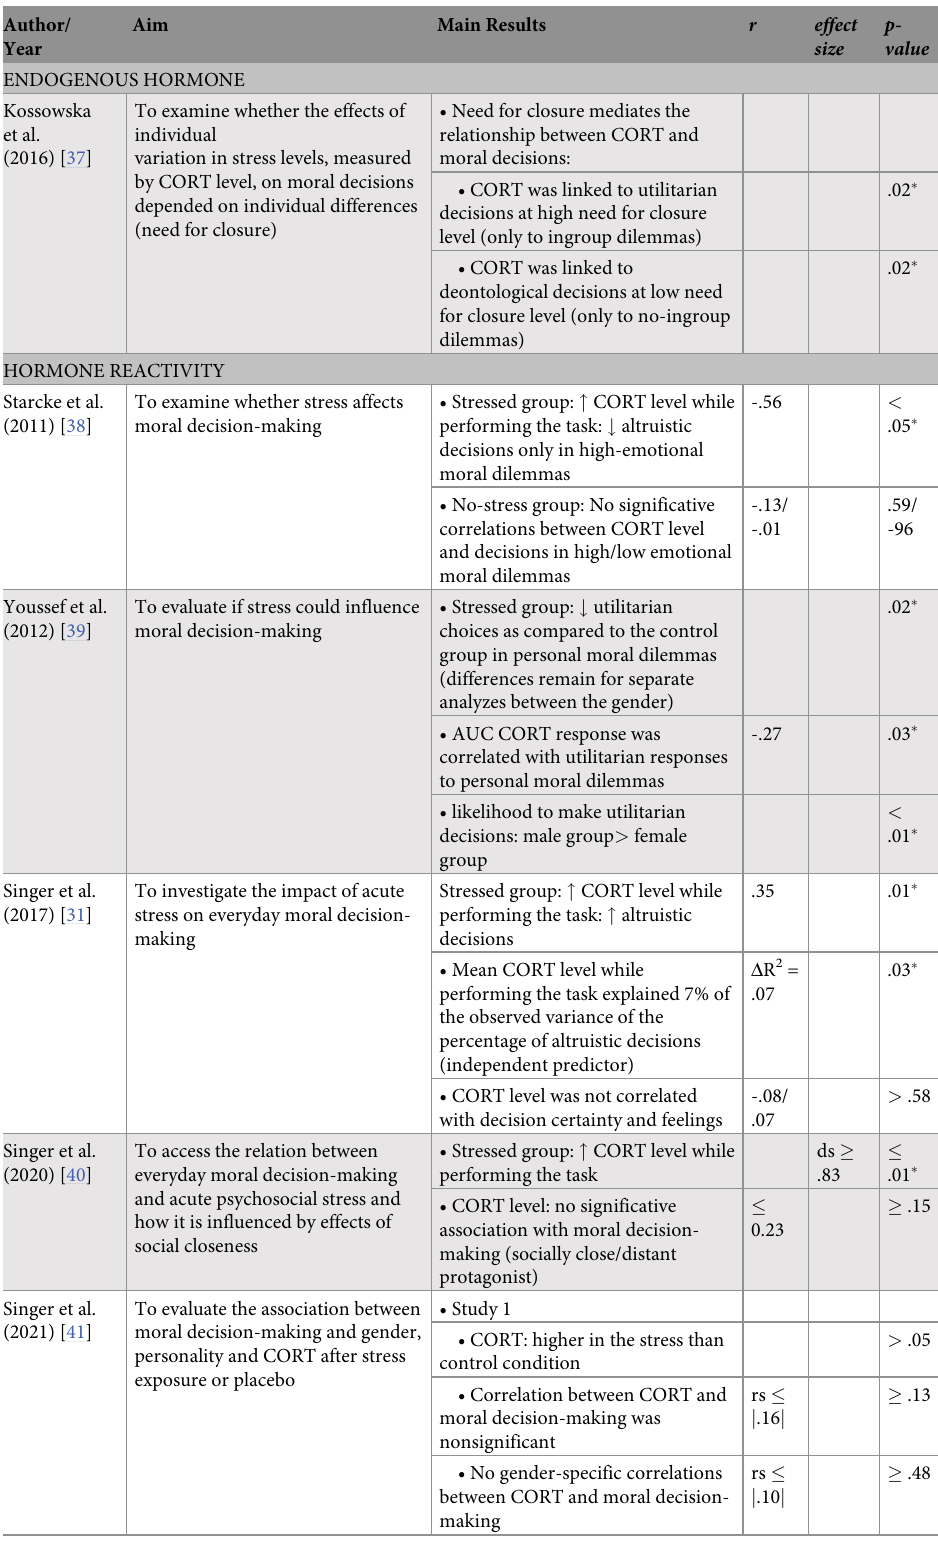
Table 2. Main results of the studies on cortisol included in this